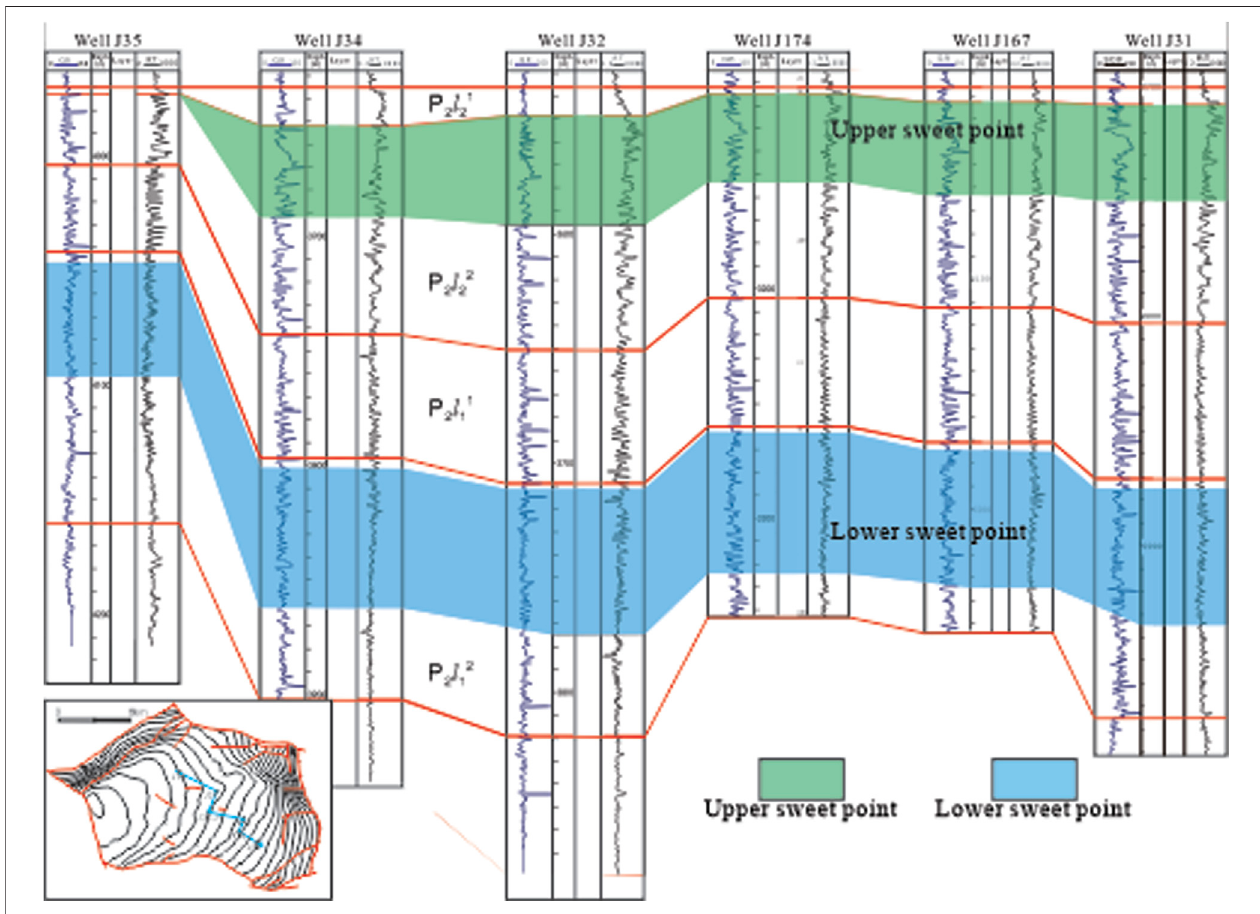
FIGURE 3 | Stratigraphic correlation of middle Permian oil layers in Jimusar Sag.